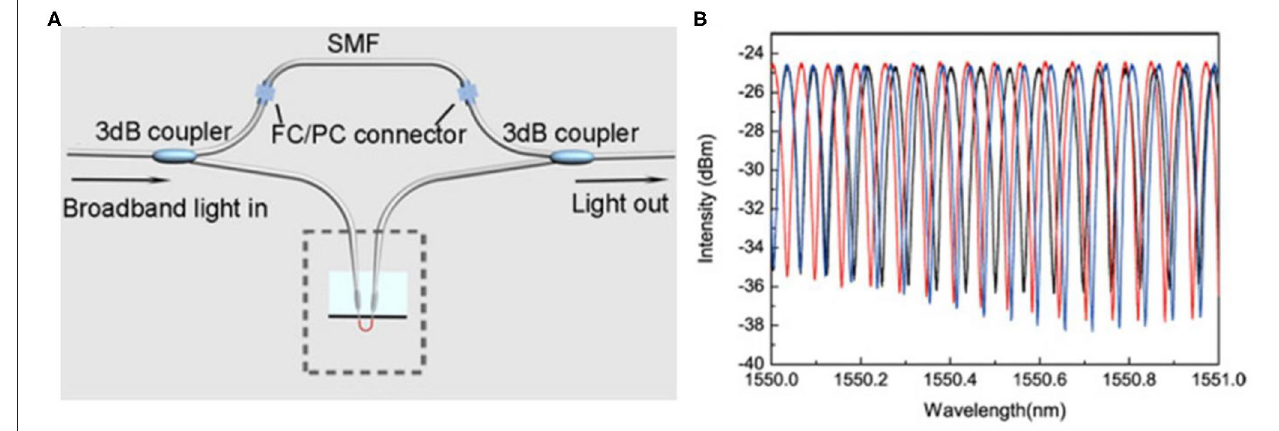
FIGURE 3 | Schematic and performance of an NW-assembled MZI sensor [17]. (A) All-fiber hybrid photonic-plasmonic MZI. (B) Spectral shifts of the interference peak when the probe is exposed to NH3 of 80 ppm (blue) and 160 ppm (red), respectively. Reprinted with permission from Li et al. [17] © The Optical Society.